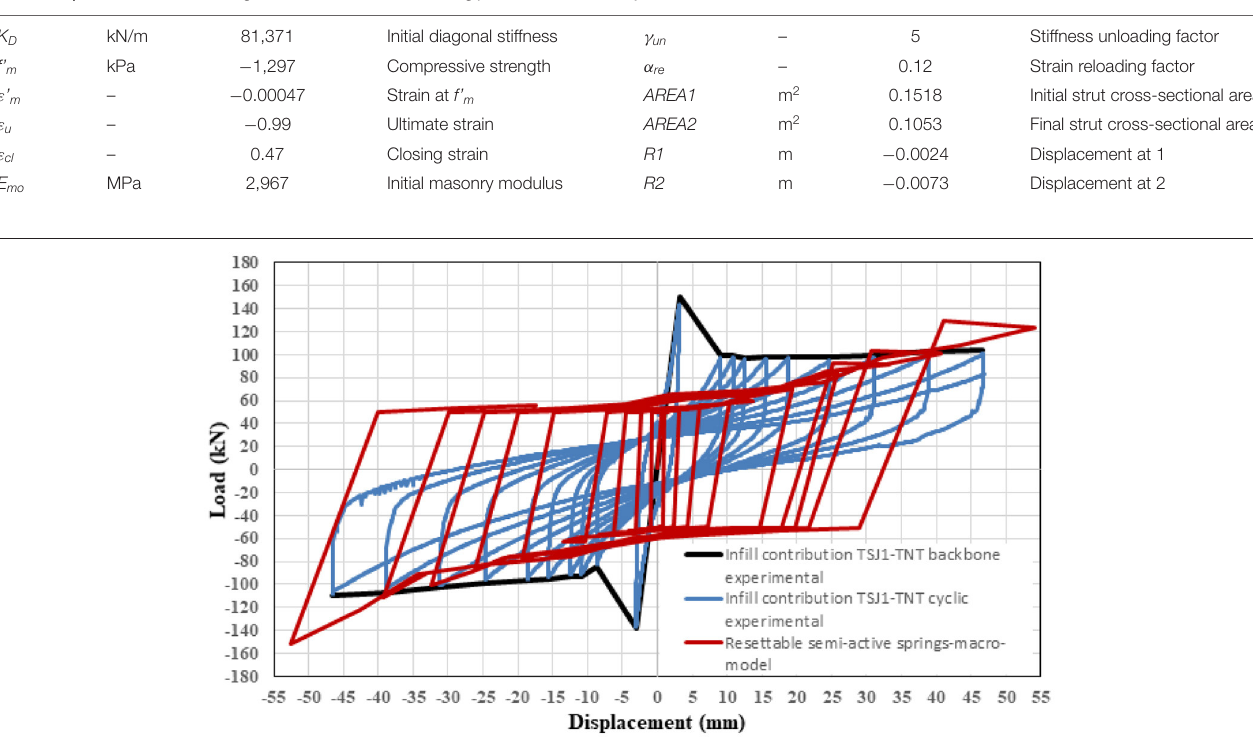
FIGURE 11 | Comparison between the force-displacement experimental curves for infill with sliding joints of the University of Pavia and numerical curvers for semi-active spring model.